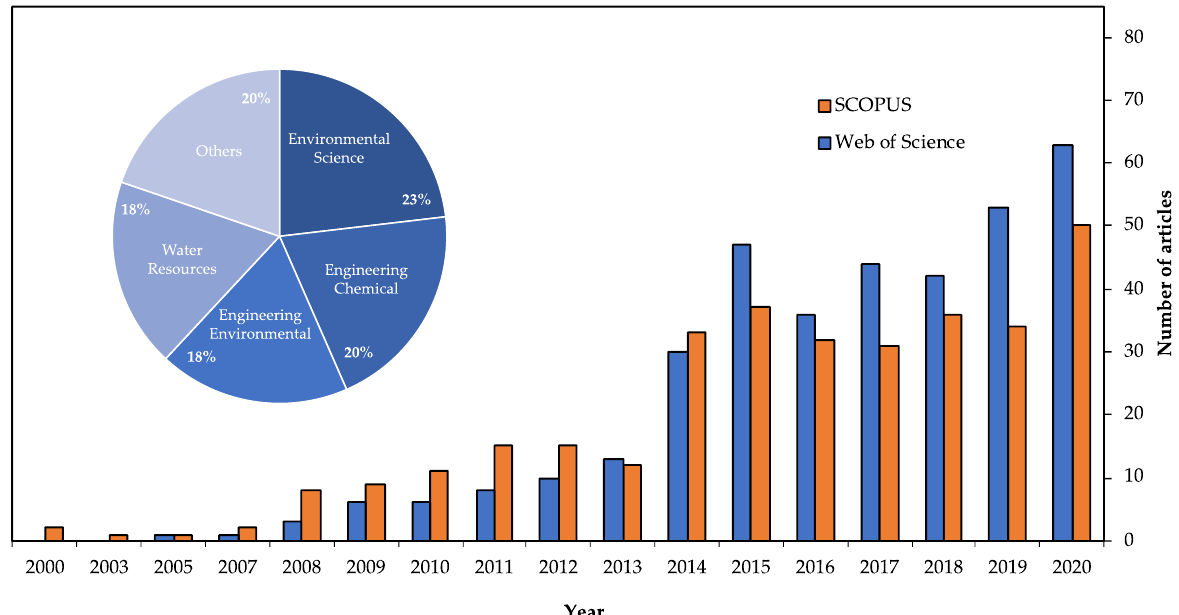
Figure 3. Graphic of articles (topic: “reverse osmosis concentrate”) from 2000 to 2020 in the Web of Science (WoS), SCOPUS, and WoS categories.